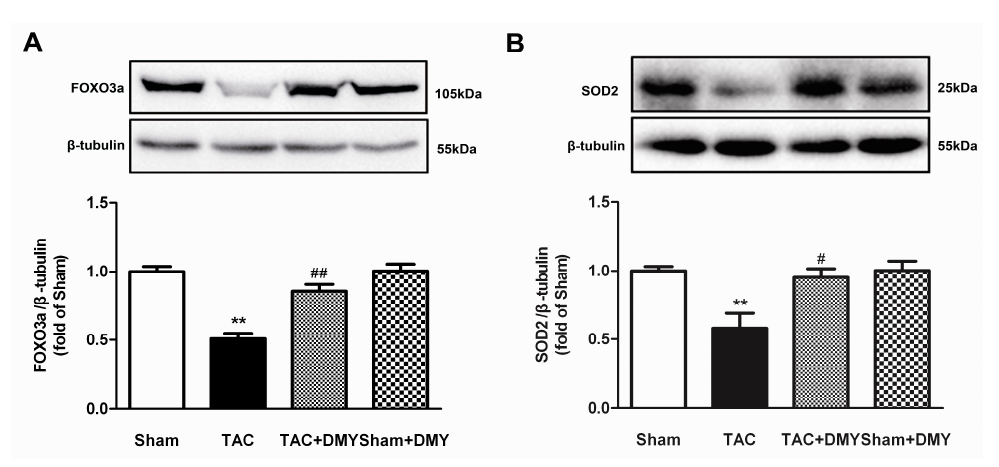
Figure 9. Effect of DMY on forkhead-box-protein 3a (FOXO3a) and SOD2 protein expression in the myocardium of mice after TAC. ( A , B ) FOXO3a and SOD2 protein expression were quantified by western blot. β -tubulin was used as a loading control. ** p < 0.01 versus Sham; # p < 0.05, ## p < 0.01 versus TAC ( n = 5).